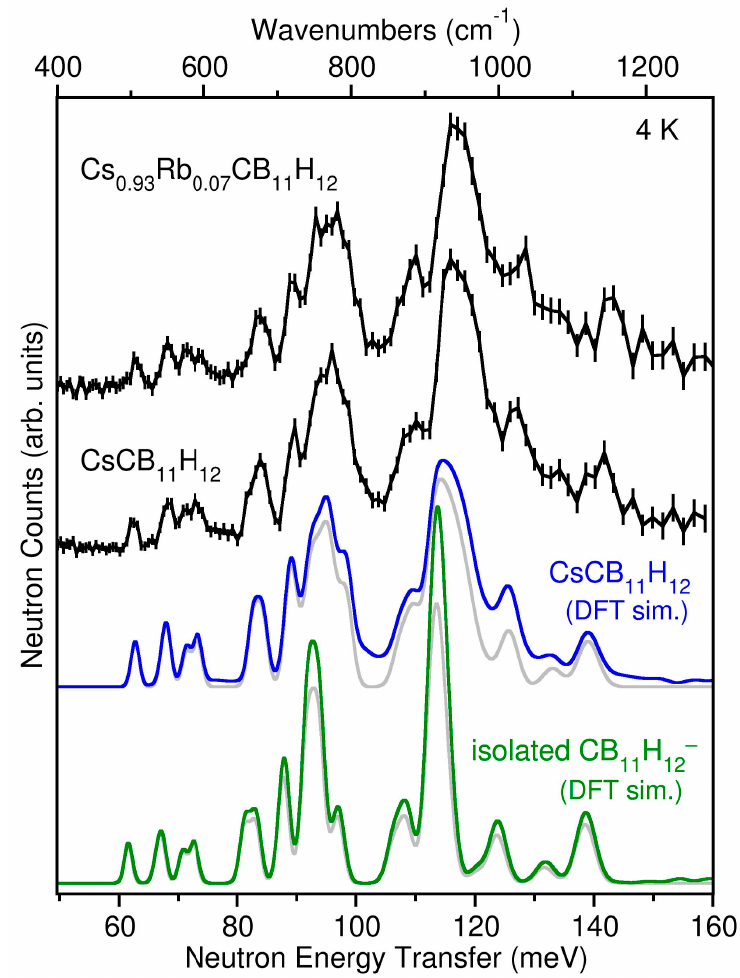
Figure 3. Neutron vibrational spectra (black) of CsCB 11 H 12 and Cs 0.93 Rb 0.07 CB 11 H 12 at 4 K compared to the simulated one + two-phonon densities of states from DFT phonon calculations of the optimized − anion (green, from ref. [2], using a γ -CsCB 11 H 12 R 3-structure (blue) and the isolated CB 11 H 12 30 × 30 × 30 supercell and full C 5 v molecular symmetry). The simulated one-phonon densities of states considering only the fundamental single-phonon modes are shown for comparison in grey. Vertical error bars represent ± 1 σ . (N.B., 1 meV ≈ 8.0655 cm − 1